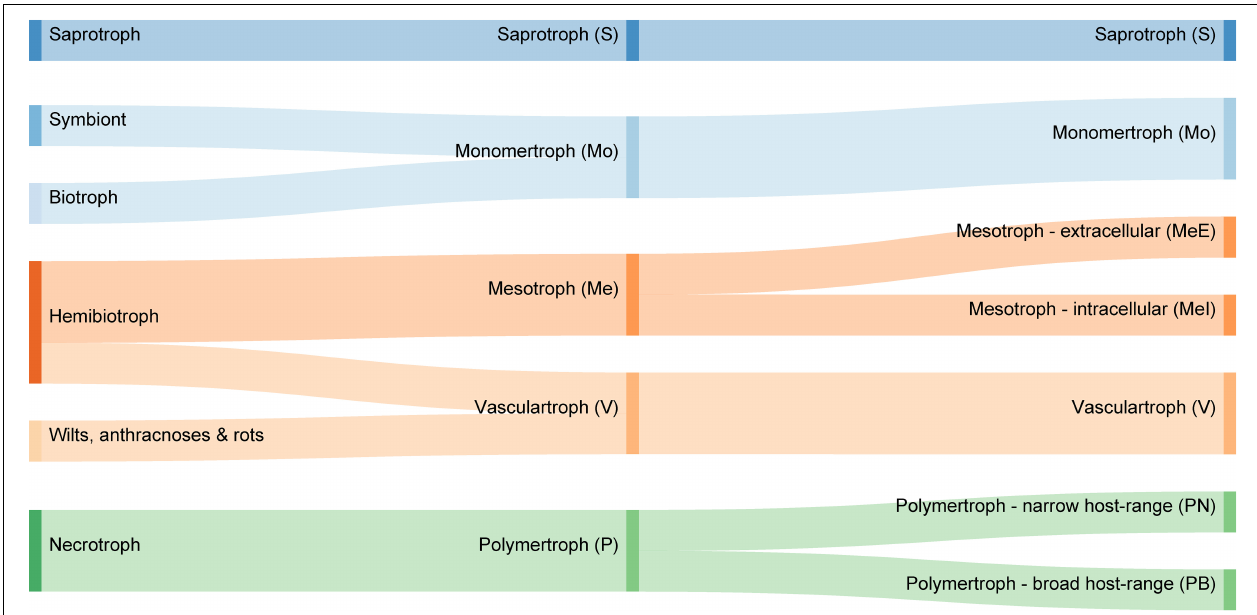
FIGURE 1 | Comparison of common trophic terms used in plant pathology literature (left) , with our proposed novel classification system of five major trophic classes (middle) and nine sub-classes (right)